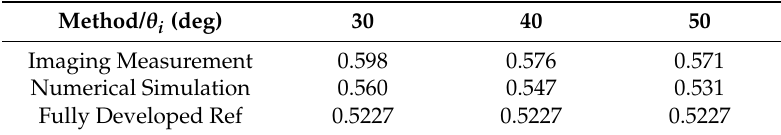
Table 6. Comparison of amplitude γ in the case of imaging resolution cell/footprint size of 30 mm, at different θ i , from measured images and simulated backscattering. Sample and computation parameters are in Tables 1 and 3(set 1).